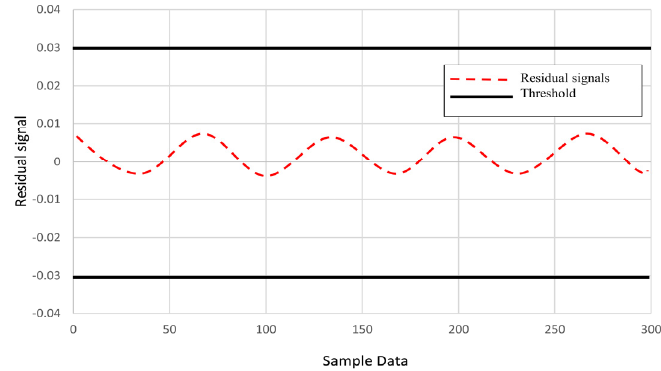
Figure 3. The sensor signal for the pipe under no-fault condition.